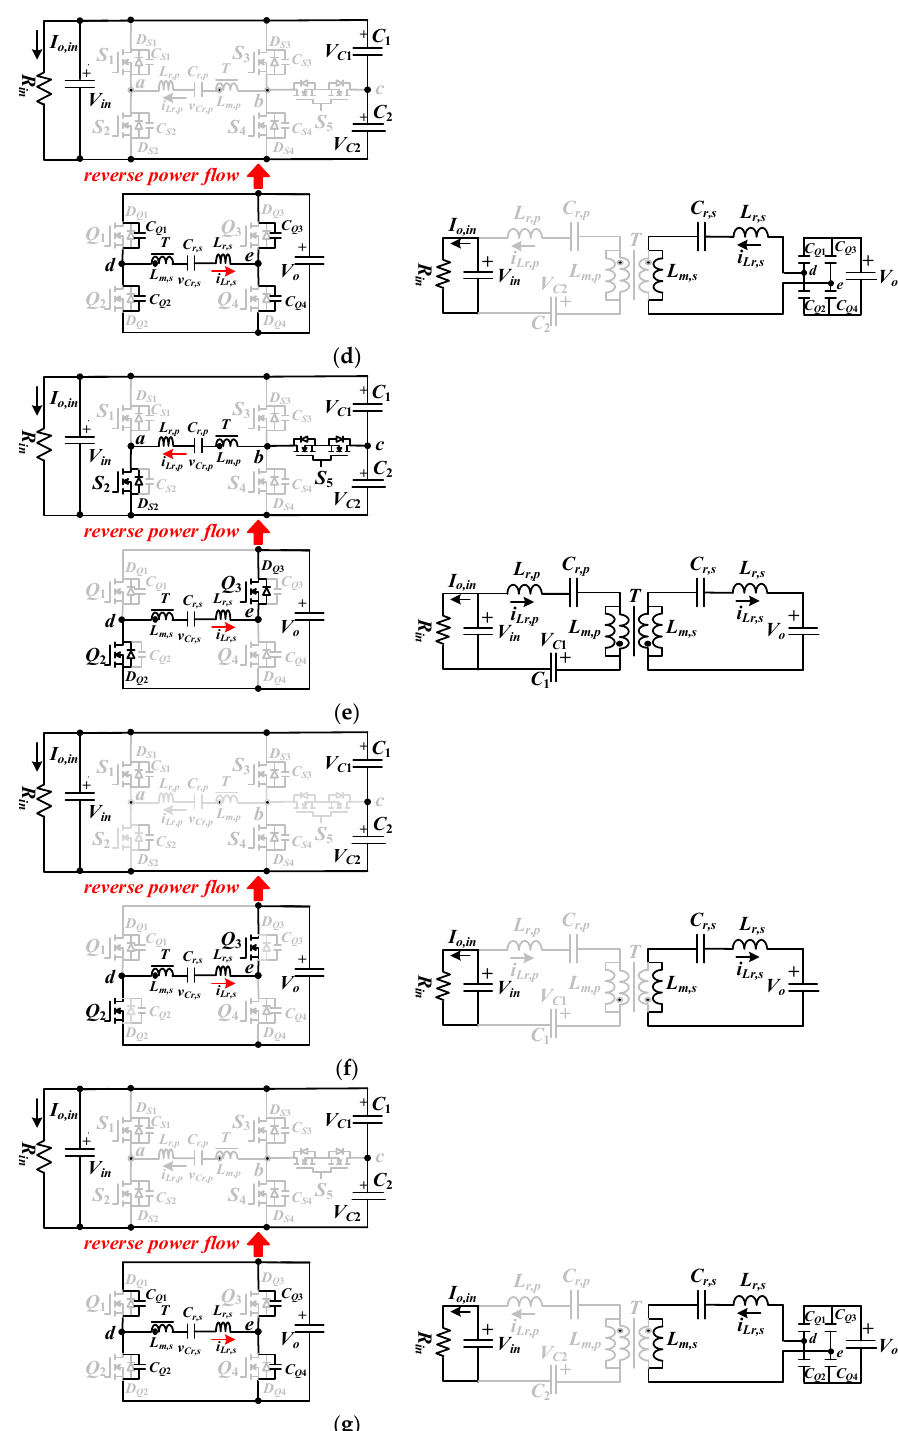
Figure 7. The corresponding mode circuits under reverse power operation: ( a ) PWM signals, ( b ) mode 1, ( c ) mode 2, ( d ) mode 3, ( e ) mode 4, ( f ) mode 5, ( g ) mode